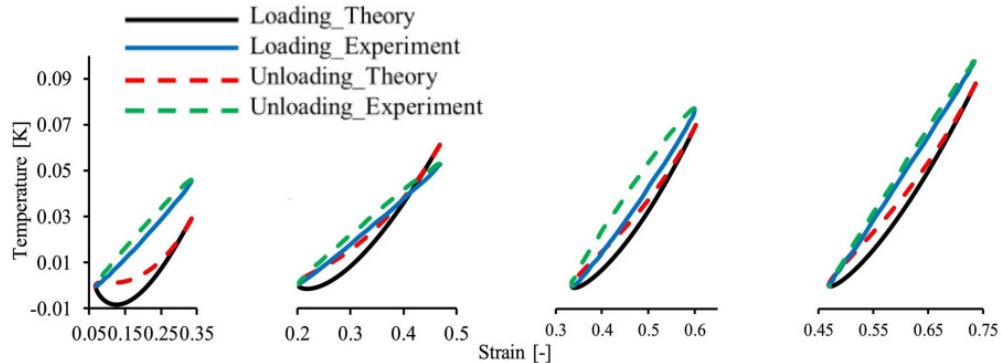
Figure 18. Temperature changes versus strain under different loading conditions [81].